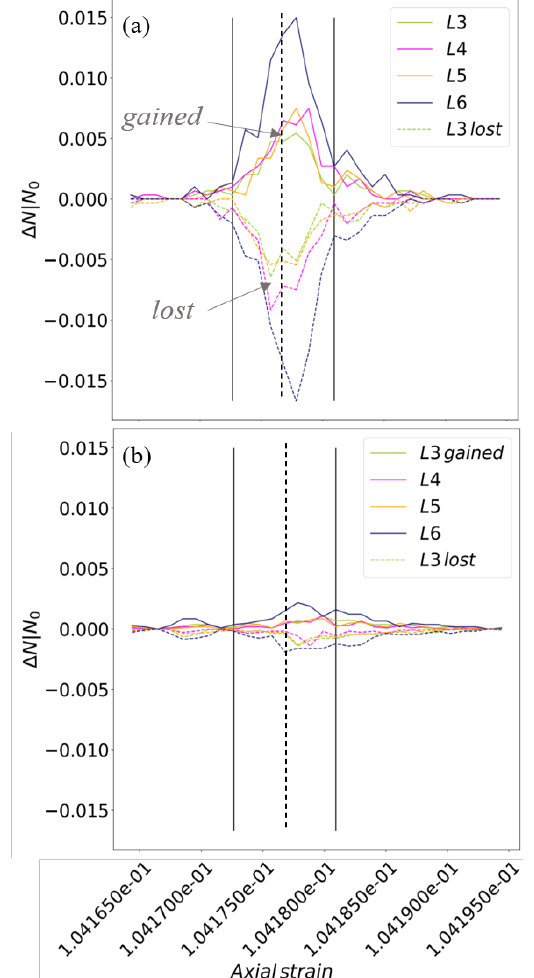
Fig. 4. Incremental evolution of grain-loops inside (a) and outside (b) the burst domain shown in Figure 1. A color is assigned to each order loops (L3, L4, L5 and L6+). Solid lines represent the creation of loops ( Δ N >0) and dotted lines represents the loss of loops ( Δ N <0). The duration of the burst is delimited by the vertical solid lines and the peak of maximum kinetic energy is displayed by the vertical dotted